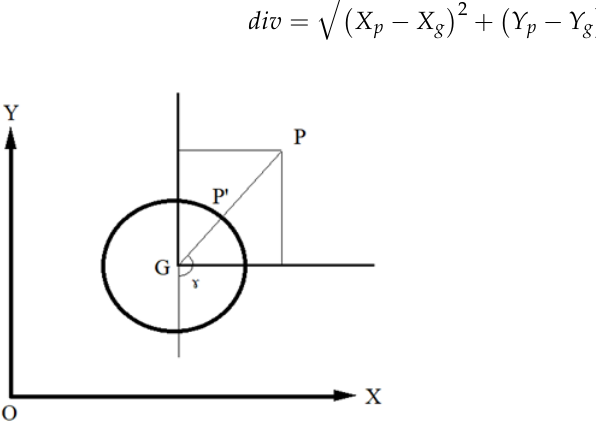
Figure 9. Deviation of Point P located in the horizontal plane, where Z = Z p .